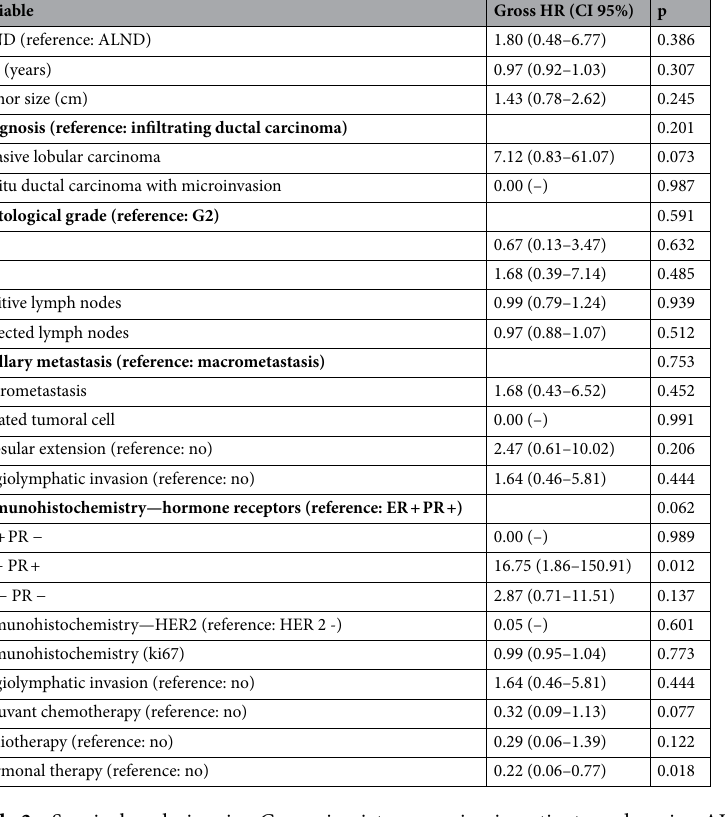
survival; patients with positive hormone receptors status lived longer (see Supplementary Table S1). Patients with negative receptors for estrogen (ER) and positive receptor for progesterone (PR) had shorter survival, but only two patients were classified as such; therefore, they were not considered (Table 1). All patients positive for HER2 received targeted therapy, and there was no difference in survival between patients with positive and nega- tive HER2 status. In the survival model, only hormonal therapy had a significant effect (p = 0.018, Table 3), and patients receiving this therapy had a 78% lower risk of death. As in the previous analysis, the two patients who were ER- and PR + were not considered. The multivariate Cox regression model included the following as predictor variables in the initial model: the intervention group (regardless of their significance), hormonal therapy (significant at 5% in the Cox univariate model), tumour size, the number of positive lymph nodes, the number of resected lymph nodes, capsular exten- sion, the size of axillary metastasis, and adjuvant chemotherapy (different characteristics by intervention group) (Table 4). In this analysis, there was no difference in survival between the groups (p = 0.536) (Table 4). However, the risk of death was 91% lower in patients undergoing hormonal therapy in the final model (p = 0.005) and 86% lower in those treated with adjuvant chemotherapy (p = 0.027). Schoenfeld residuals testing showed that the hazards were proportional in the initial model (p = 0.453) and at the end (p = 0.194), indicating the absence of violation of this assumption. Locoregional recurrence. Locoregional recurrence was a rare event, with only four patients having disease recurrence: 7.3% of patients in the ALND group and 1.7% in the SLND group (p = 0.3075). Recurrence occurred in all cases within 18 months of follow-up. Survival after locoregional recurrence was 10.1 years (95%CI 9.62– 10.40), and there was no statistically significant difference between the groups (p = 0.196) (see Supplementary Table S2). Figure 4 shows survival after locoregional recurrence per group.